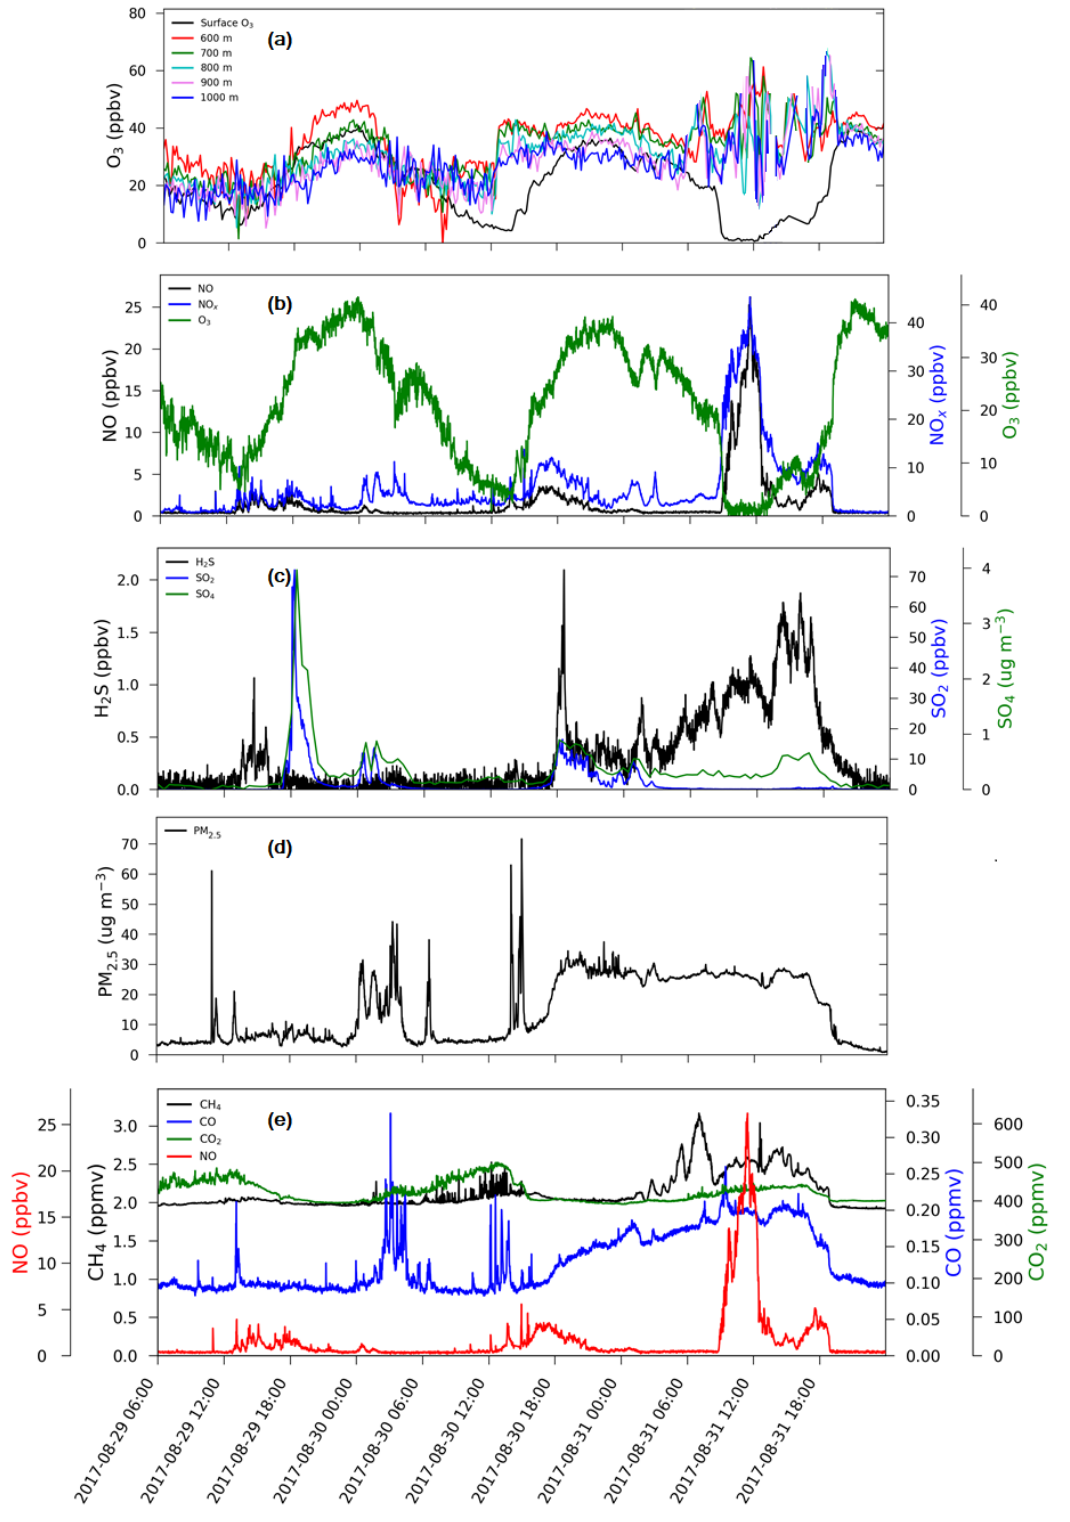
Figure 15. (a) DIAL ozone traces at different altitudes compared to surface ozone for the same period as Fig. 14. CAM1 surface measure- ments for same time period of (b) ozone and NO x ; (c) sulfur compounds; (d) PM 2 . 5 ; and (e) CH 4 , CO, CO 2 and